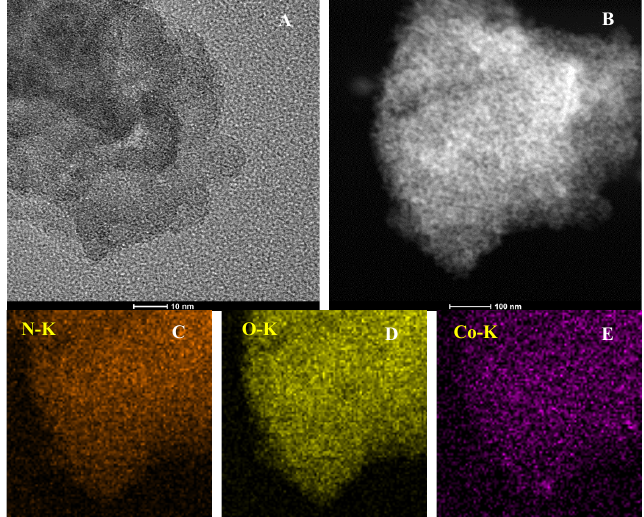
Figure 1. HRTEM ( A ) and STEM ( B ) images of the covalently anchored catalyst SiO 2 ‐ APTES ‐ EASA ‐ Co and its elemental mapping images ( C – E ). 2.1.4. Structural Properties The anchored Co ‐ Schiff base catalysts were characterized by FT ‐ IR and the obtained spectra were compared with those of the support SiO 2 and the aminated intermediate